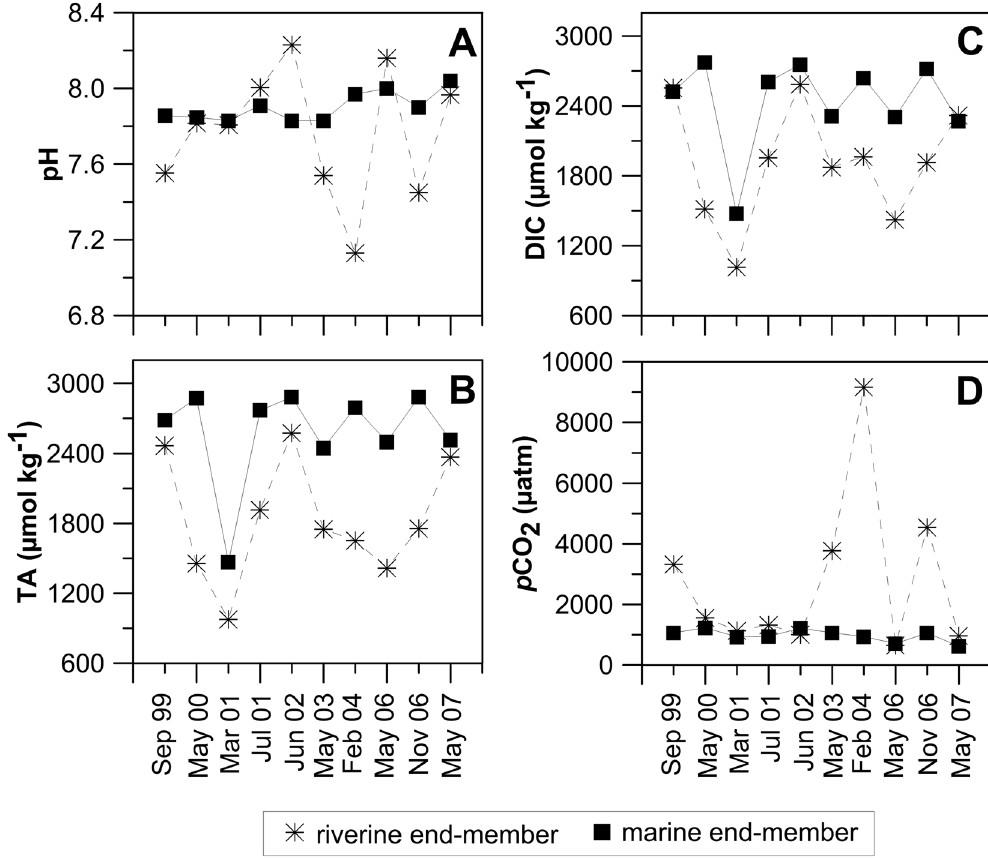
Figure 4. Riverine (✳) and marine ( ■ ) end-members values of ( A ) pH, ( B ) total alkalinity (TA), ( C ) dissolved inorganic carbon (DIC) and ( D ) CO 2 partial pressure ( p CO 2 ) throughout to the 10 surveys undertaken in Tagus